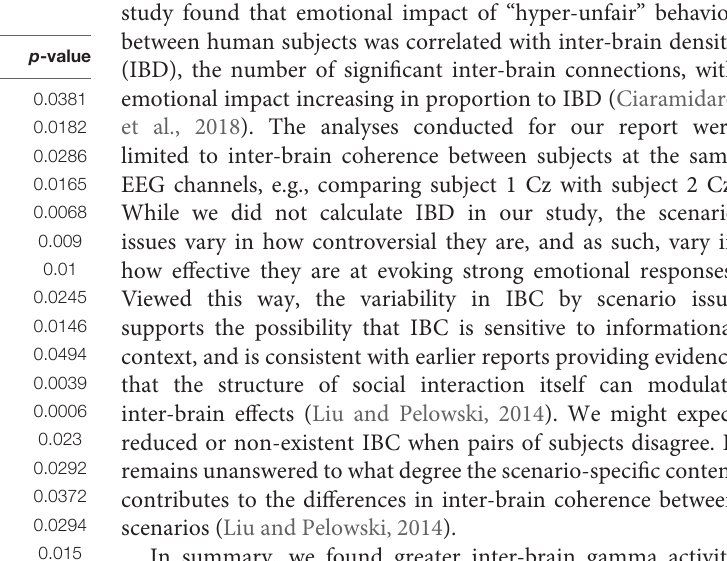
TABLE 3 | Significant IBC in group unanimity.